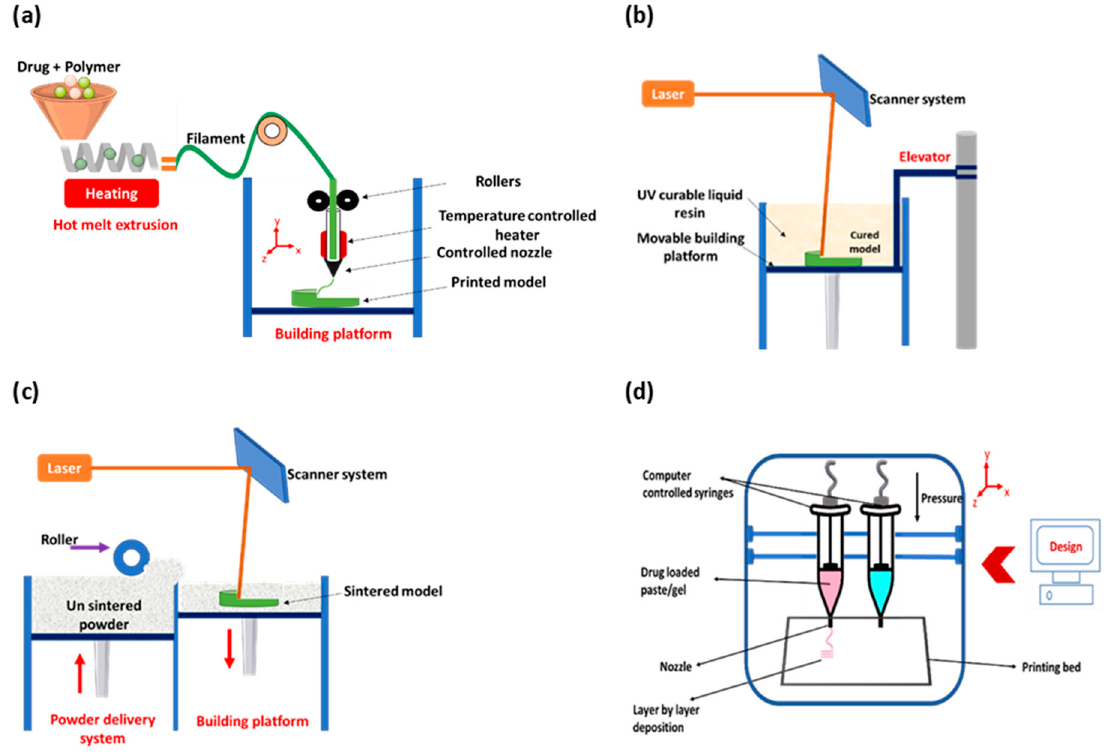
Figure 4. A schematic diagram illustrating ( a ) FDM ( b ) SLA ( c ) SLS ( d ) SSE printers (Adapted from [51]).